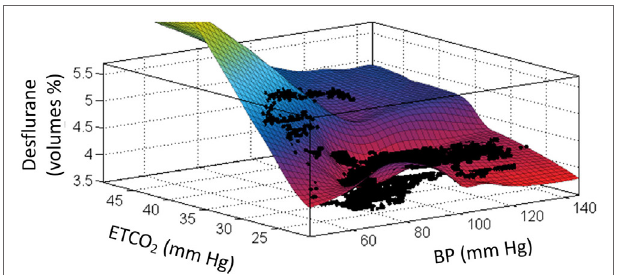
FiGUre 1 | An example of the interaction between mean blood pressure ( x -axis), end-tidal CO 2 ( y -axis), and end-tidal anesthetic agent (desflurane) concentration ( z -axis) in one patient. This locally weighted smoothing linear regression had an R 2 fit of 0.758 for these 13,014 data points. These data were collected intraoperatively in this patient using a data acquisition system downloading at 1 Hz. See the text and Ref. (25) for further